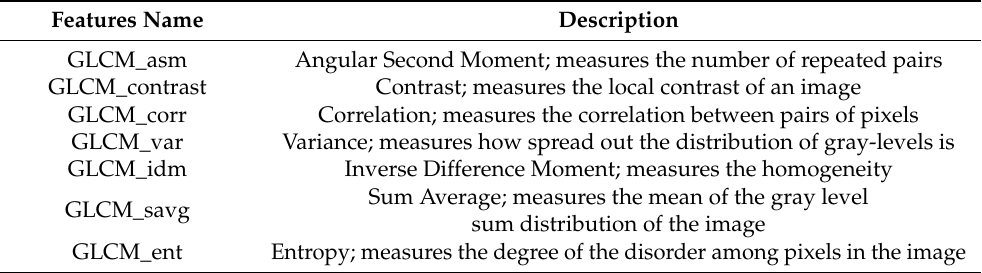
Table 3. Texture features calculated from GLCM used in this